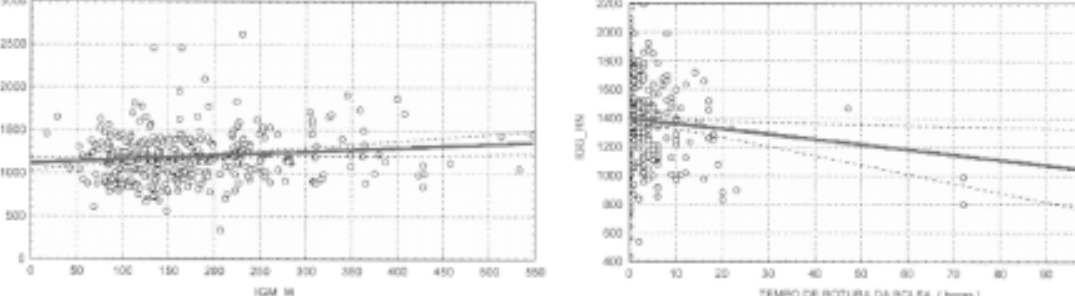
FIGURA 8 - Reta de regressªo e equa(cid:231)ªo correspondente da rela(cid:231)ªo IgG do Rne tempo de ruptura da bolsa (cid:226)mnica IGG_RN(mg%)= 1394,1 (cid:150) 3,562*BOLSA ROTA (HORAS) Correla(cid:231)ªo: r=0,1314 p=0,018